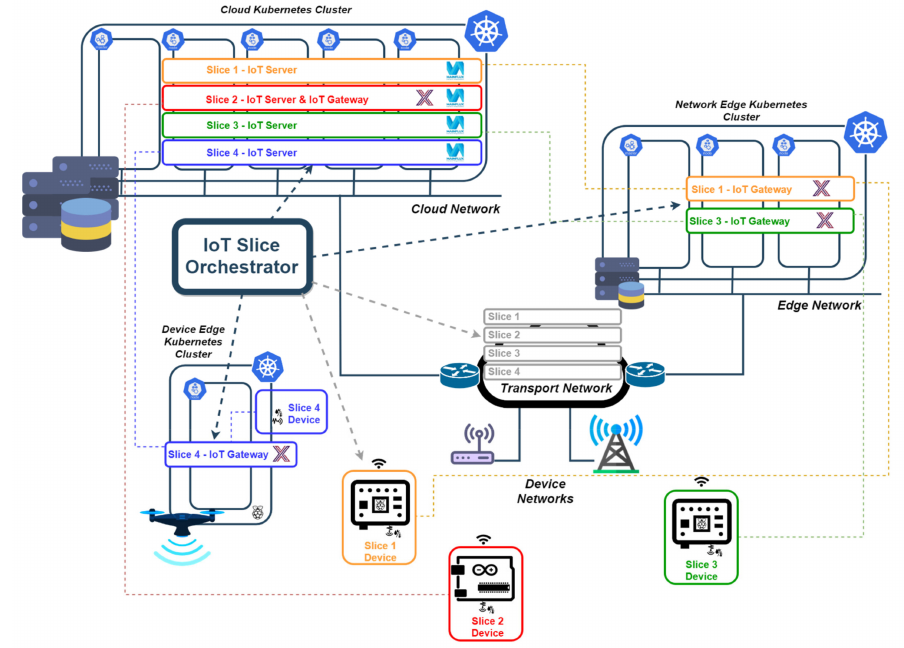
Figure 4. Example of deployment of IoT end-to-end architecture using edge and cloud computing; and network